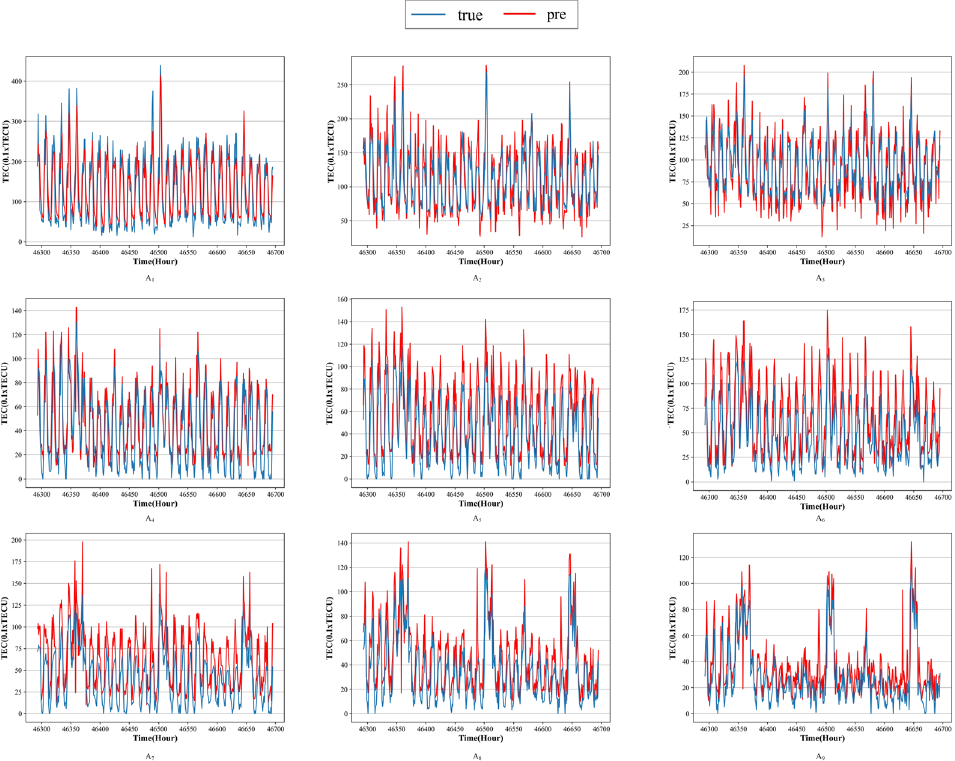
Figure 11. Prediction effect of LSA periods in 9 regions in Figure 1.